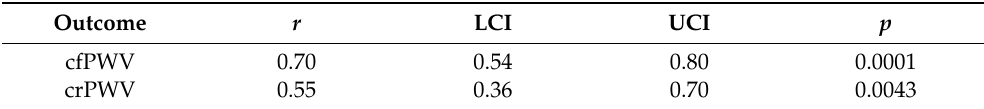
Table 2. Correlations between baseline estimated (ePWV) with carotid–femoral (cfPWV) and carotid– radial (crPWV) pulse wave velocities (PWV). Outcome r LCI UCI cfPWV